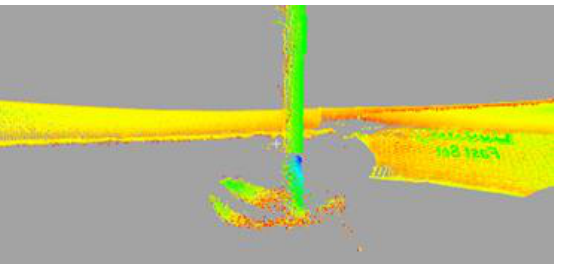
Figure 21. Three-dimensional laser scan after refraction correction for Trial 6 [36] (used with per- mission).